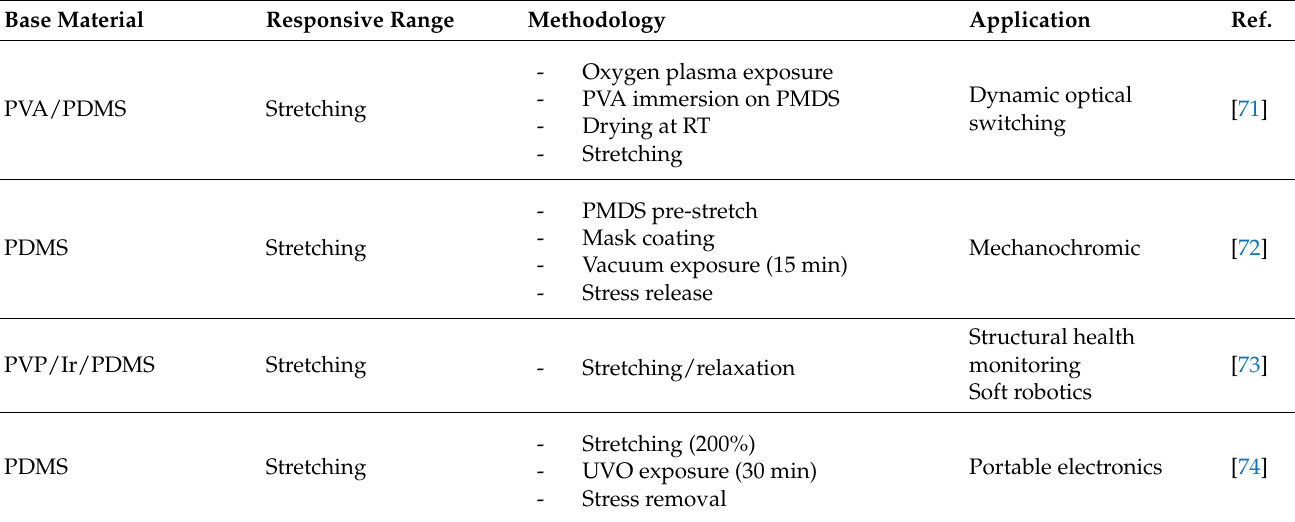
Table 4. Summary of mechanical (stress/stretch) listed in Section